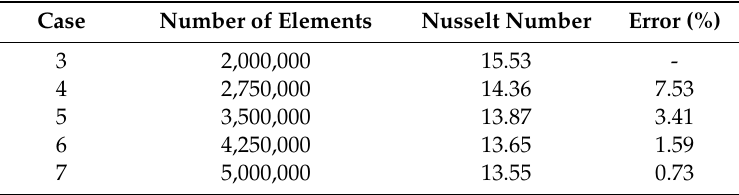
Table 2. Grid independency analysis.